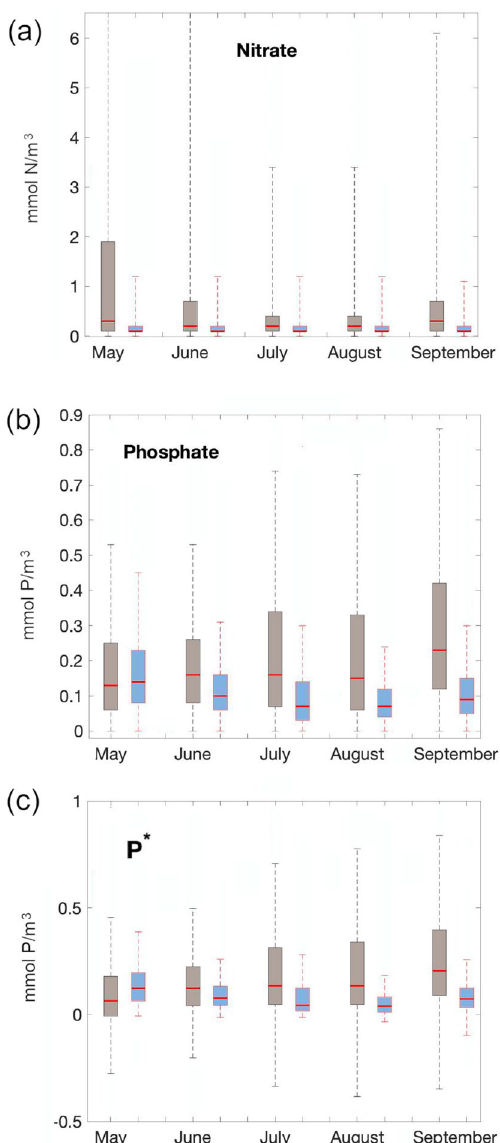
Figure 4. Nutrient concentrations of coastal (brown whisker plots) and off-shore surface waters (blue whisker plots). Panel ( a ) refers to nitrogen, ( b ) to phosphate and ( c ) to P* (i.e., phosphate in excess to the P:N Redfield- ratio 1:16). The central red marks indicate the respective medians and the colored squares the 25th and 75th percentiles. The whiskers extend to the most extreme data points (outliers, here defined as exceeding 1.5 times the interquartile range, are discarded). This figure was created with Matlab (https:// www. mathw orks. com/ produ cts/ matlab.